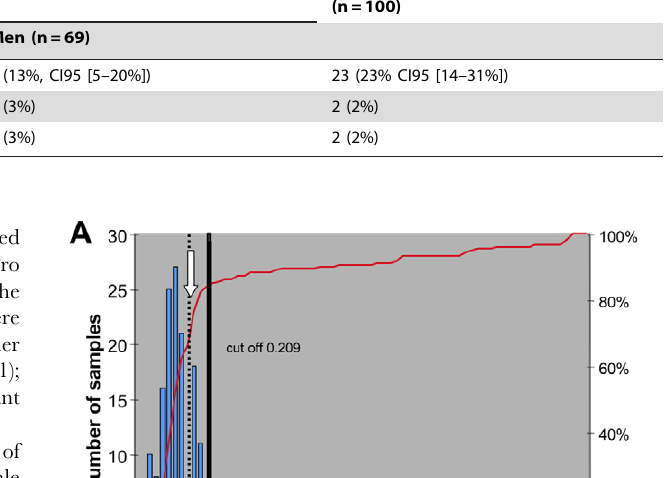
Serological markers